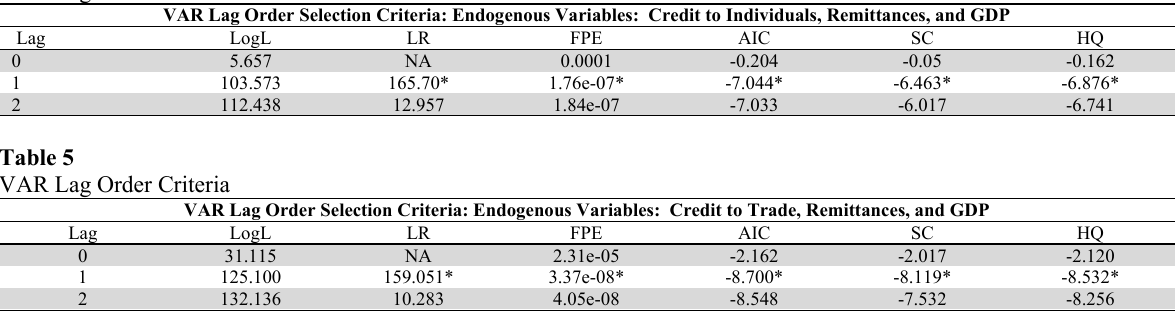
VAR Lag Order Criteria